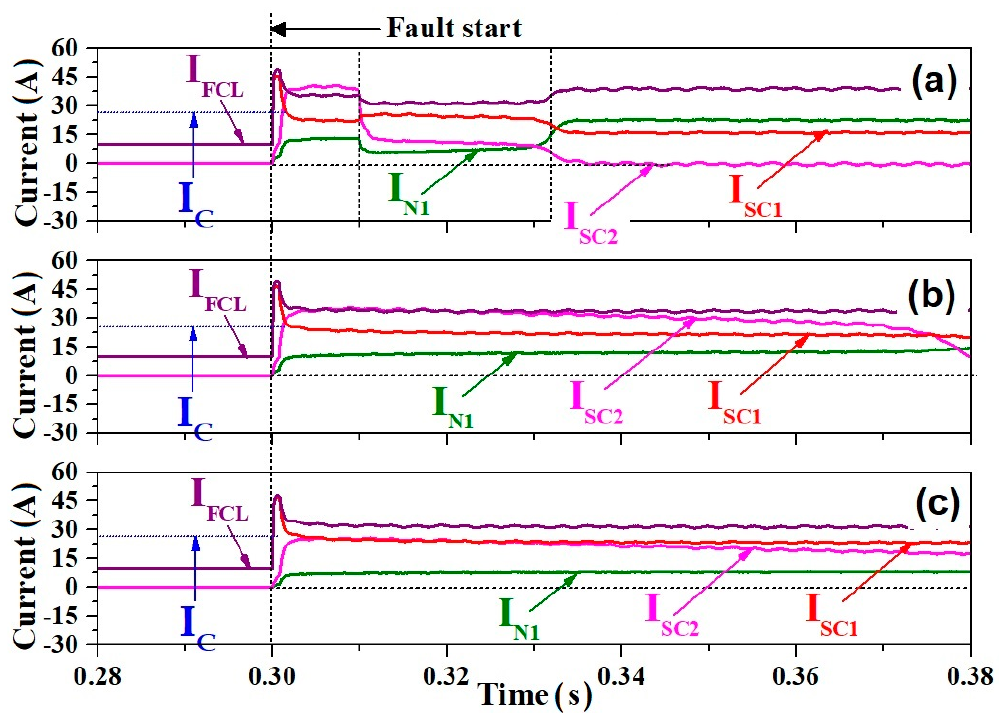
Energies 2020 , 13 , x FOR PEER REVIEW Figure 4. Current waveforms due to the CLR’s resistance: ( a ) R S = 1.15 Ω ; ( b ) R S = 2.3 Ω ; ( c ) R S = 4.6 Ω . Figure 4. Current waveforms due to the CLR’s resistance: ( a ) R S = 1.15 Ω ; ( b ) R S = 2.3 Ω ; ( c ) R S = 4.6 Ω .